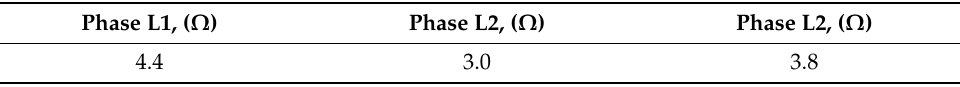
Table 3. One-phase short-circuit impedance estimation for Object 2.